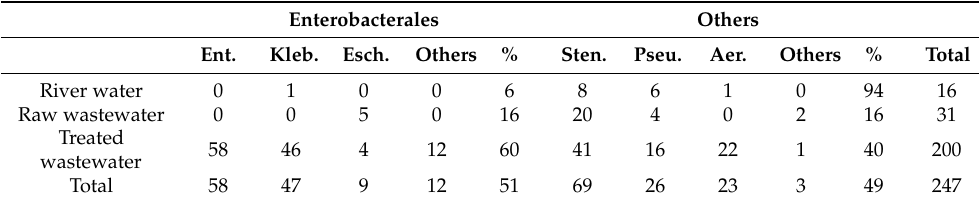
Table 2. Results of identification of genera of meropenem-resistant colonies totaled by each sampling